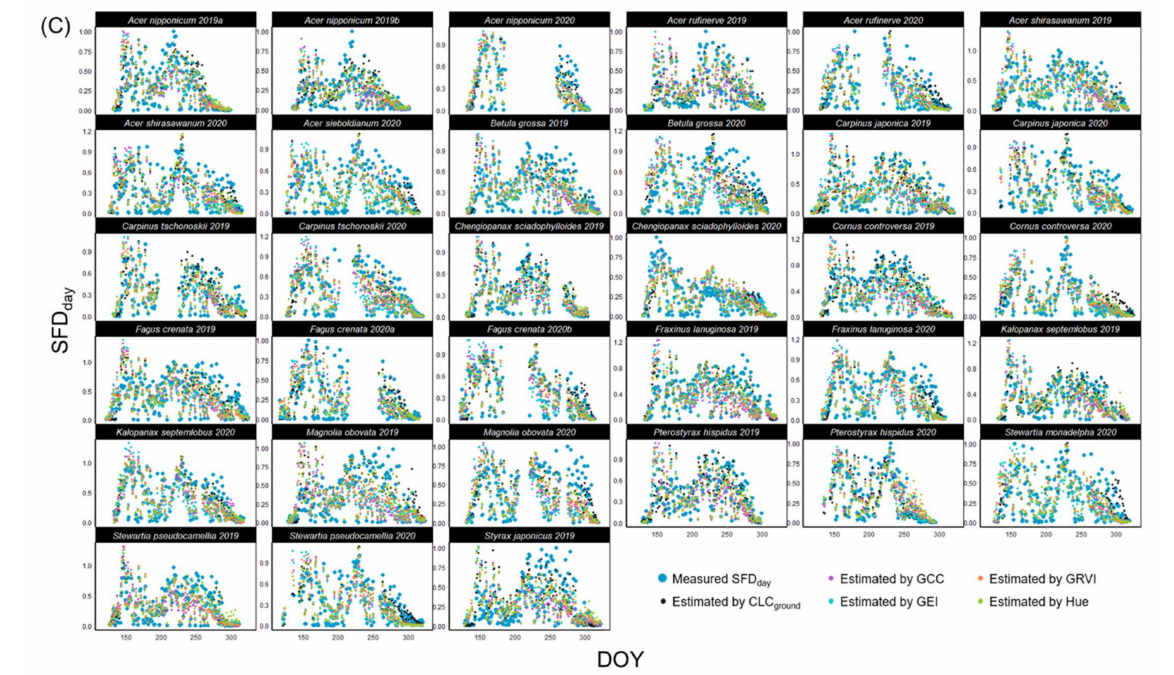
Figure A7. Comparison of the daytime total sap flux density (SFD day ) values estimated by leaf phenological metrics and the measured values; individual trees basis ( A ), all pooled data ( B ), and comparison of seasonal trajectories ( C ). Measured SFD day values are normalized to the scale from 0 to 1, and the scale of the estimated SFD day was adjusted accordingly. The solid lines in panels ( A , B ) are 1:1 lines. Root-mean-square error and coefficient of determination of linear regression analysis for the data in panels ( A , B ) are shown in Figure 5. Abbreviations: CLC ground , crown leaf cover based on the ground observation; GCC, green chromatic coordinate; GEI, green excess index; GRVI, green-red vegetation index; DOY, day of the year. Table A1. Details of the UAV survey and quality of the orthophoto derived using Context Capture. Abbreviations: DOY, day of the year; RMSE, root-mean-square error; nd, not determined. * Two of the seven ground control points (GCPs) showed high RMSE values (1.7–2.0 m) due to a small number of overlapping aerial photos around the